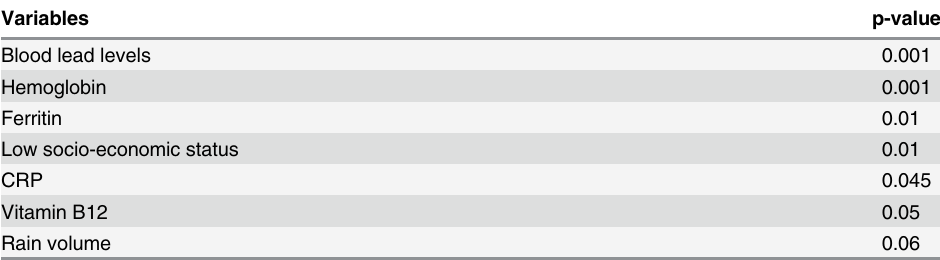
Table 2. Univariate analyses of variables associated with malaria risk at 12 months.